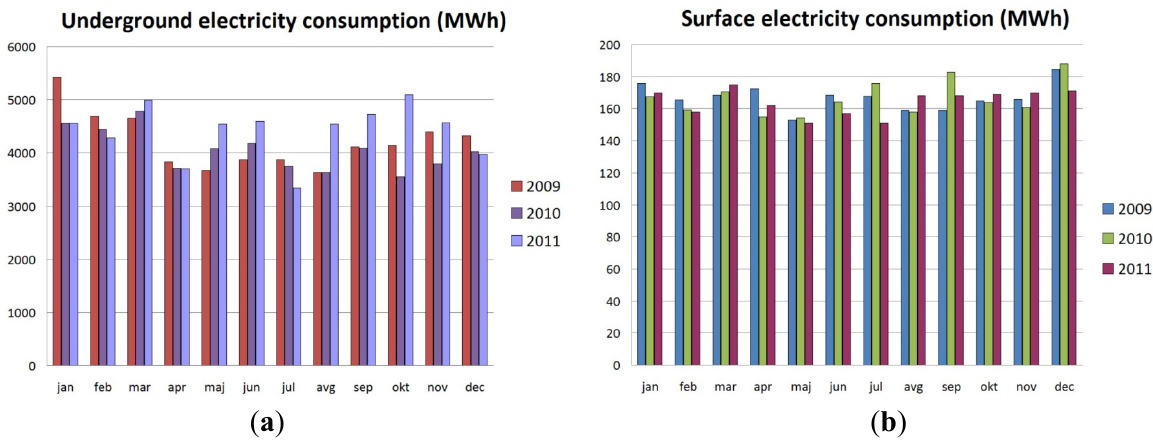
Figure 9. Electricity consumption in years 2009 to 2011: ( a ) in underground mining processes; ( b ) on surface processes.